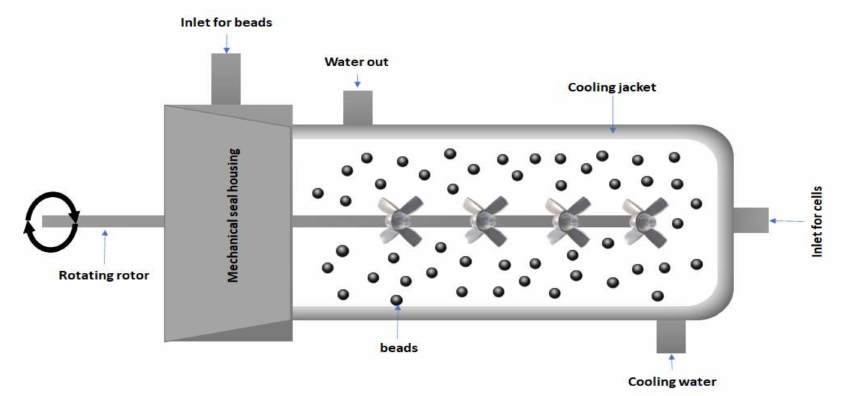
Figure 3. Bead Milling (Inspired from Diels and Michiels